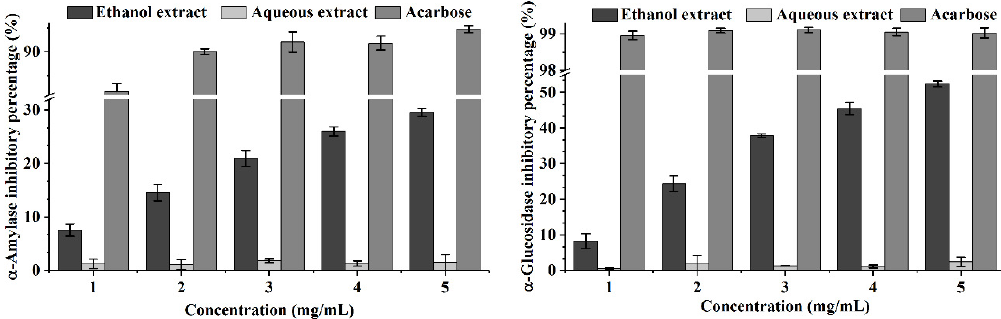
Figure 1. Antihyperglycemic activity of ethanol extract and aqueous extract obtained from wild L. deliciosus.